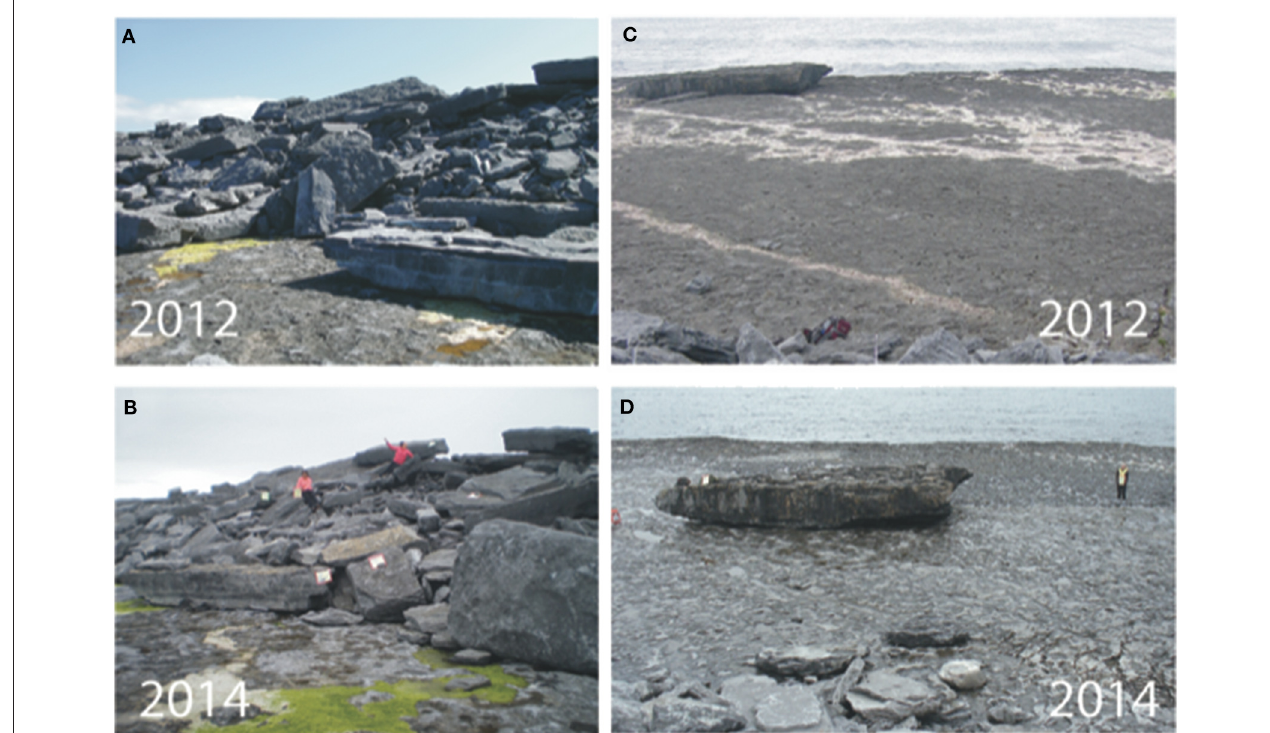
FIGURE 3 | Examples of Aran Islands CBD that underwent change during the 2013-2014 storms. (A,B) show repeat photography of a site on Inishmaan, at the far end of the coastline in Figure 1A . There are many differences in clast configuration between the two images, but the tagged boulders in (B) are clasts 754, 757, 759, 761, 762, and 763 (location 60) in Supplementary Table 1 . (C,D) show a site on Inishmore, close to the area shown in Figure 1B . This is location 16 in Supplementary Table 1 , boulder number 261. The boulder weights about 210t and, from a starting location 10m above sea level and 27m inland, it moved 22m in the 2013-2014 storms to its current location 49m inland (Cox,